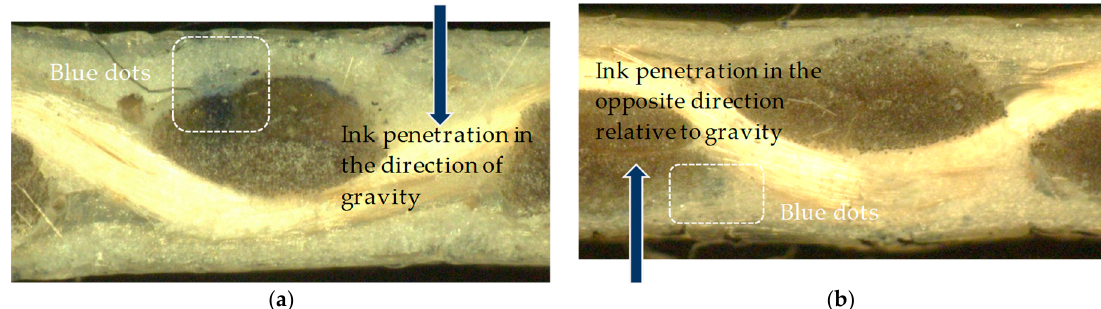
Figure 18. Ink penetration through the coating (blue pigments) after six days of watering, glass-PTFE type IV, the first batch according to Table 3; cross-section view cut through weft yarns: ( a ) ink penetration in the direction of gravity and ( b ) ink penetration in the opposite direction of gravity.